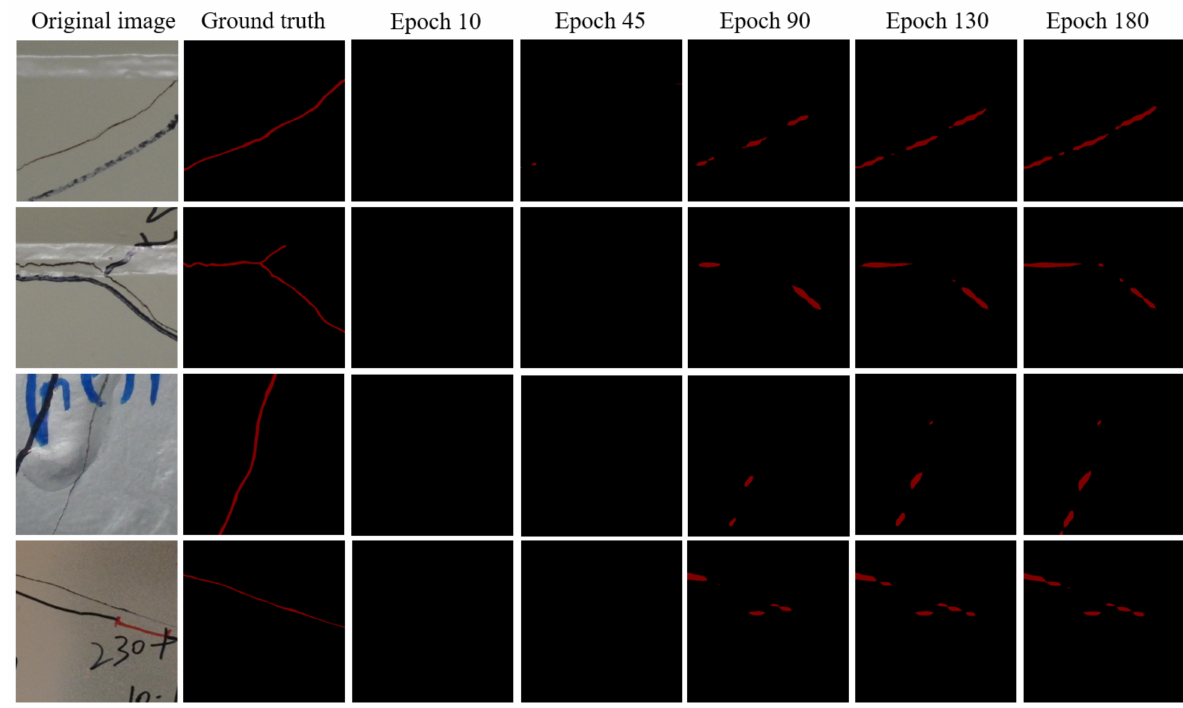
Figure 5. Predictions examples on the generated test dataset using the weights at different epochs: